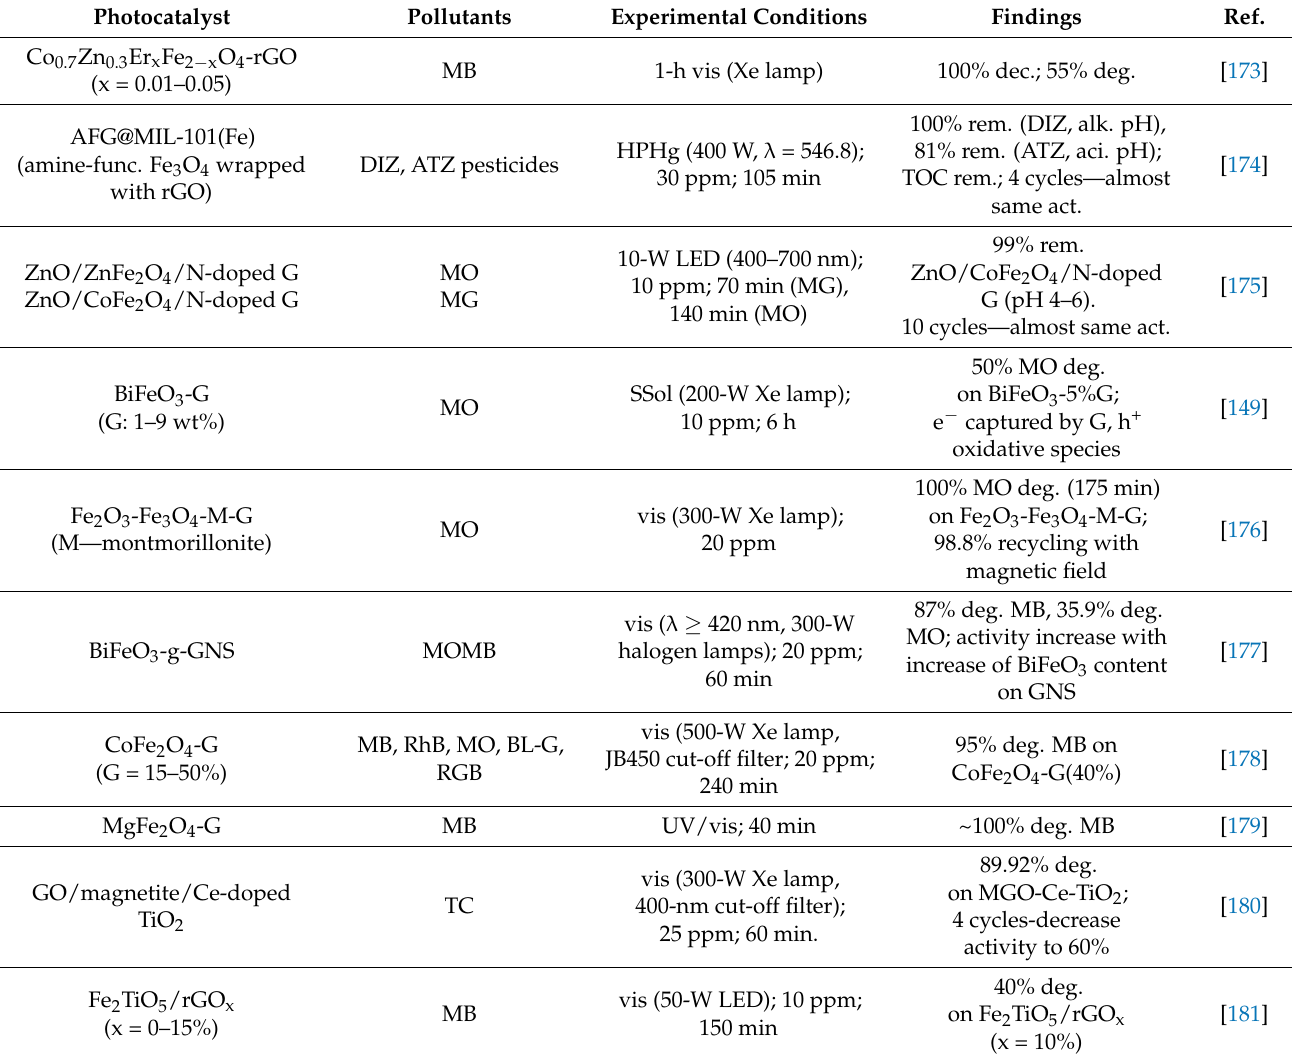
Table 4. Summary of selected graphene-magnetic NPs photocatalysts. Photocatalyst Pollutants Experimental Conditions Findings